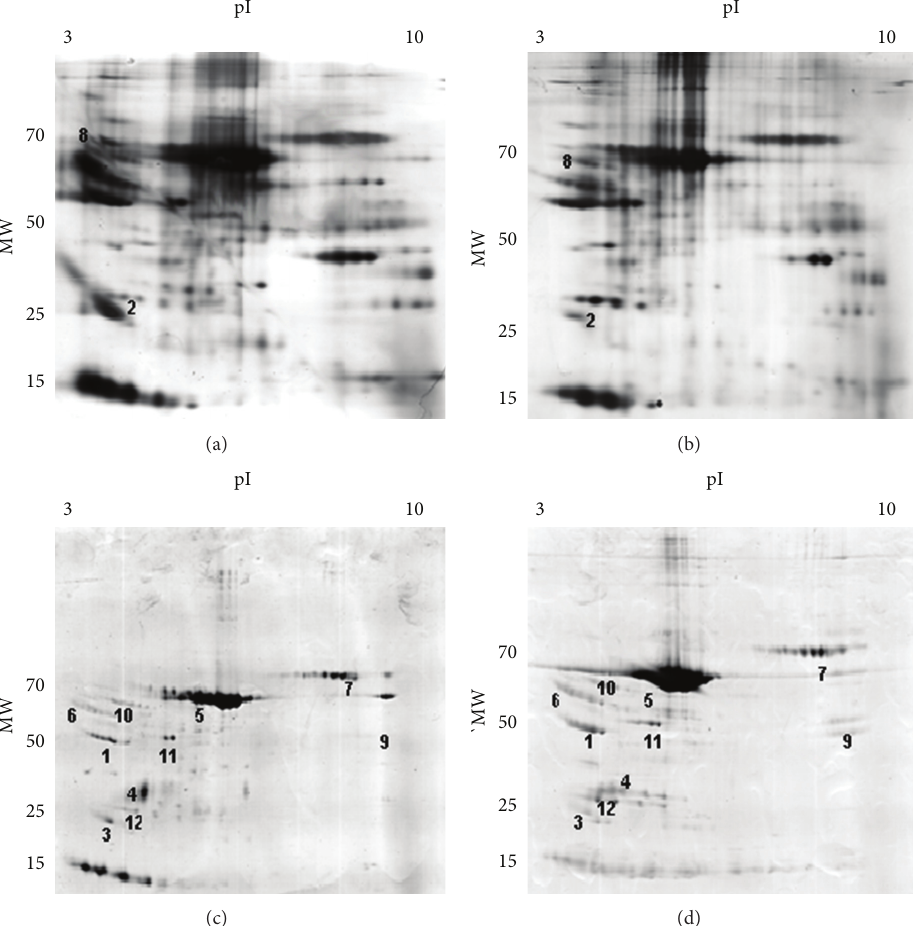
F 3: Two-dimensional gel electrophoresis using CSF from: (a) and (c): 6 month-old Wistar-Kioto rats; (b) and (d) 6 month-old SHR rats. (a) and (b) gels were obtained with silver staining and (c) and (d) were stained with Coomassie blue. e approximate isoelectric point (pI) and molecular weights (MW) are shown. e numbers in the gels correspond to the numbering in Table 1.